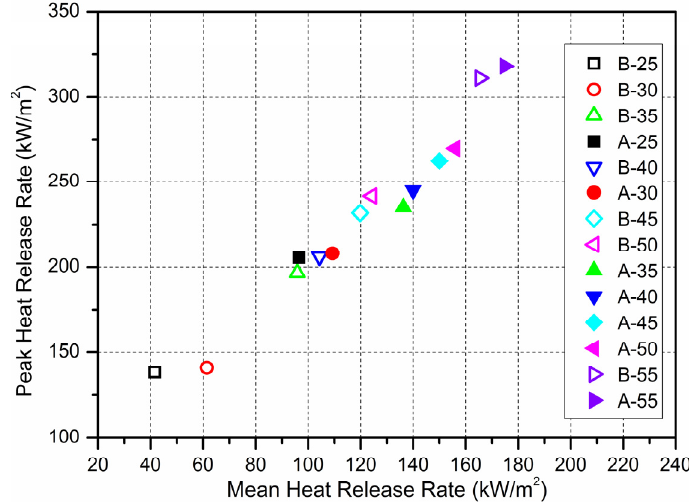
Figure 6. Plot of PHRR against MHRR for the material A and B tested at different external heat fluxes.